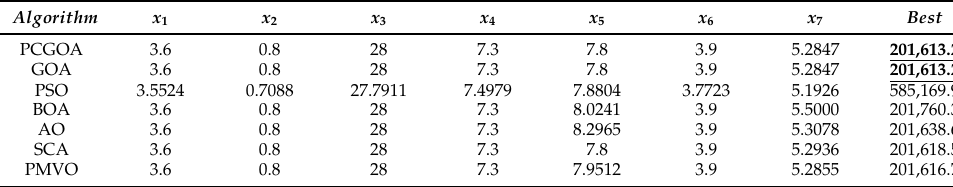
Table 7. Comparison results of each algorithm for the speed reducer design